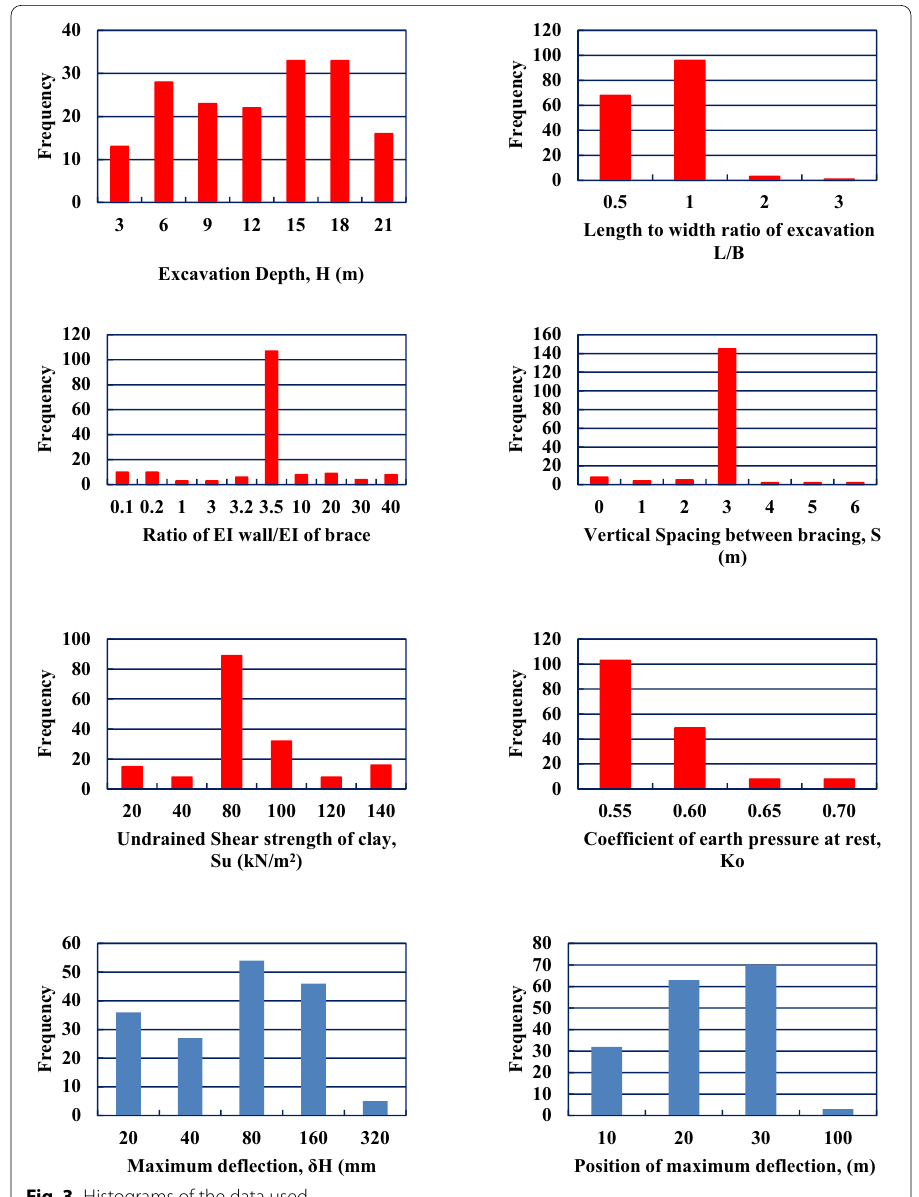
Fig. 3 Histograms of the data